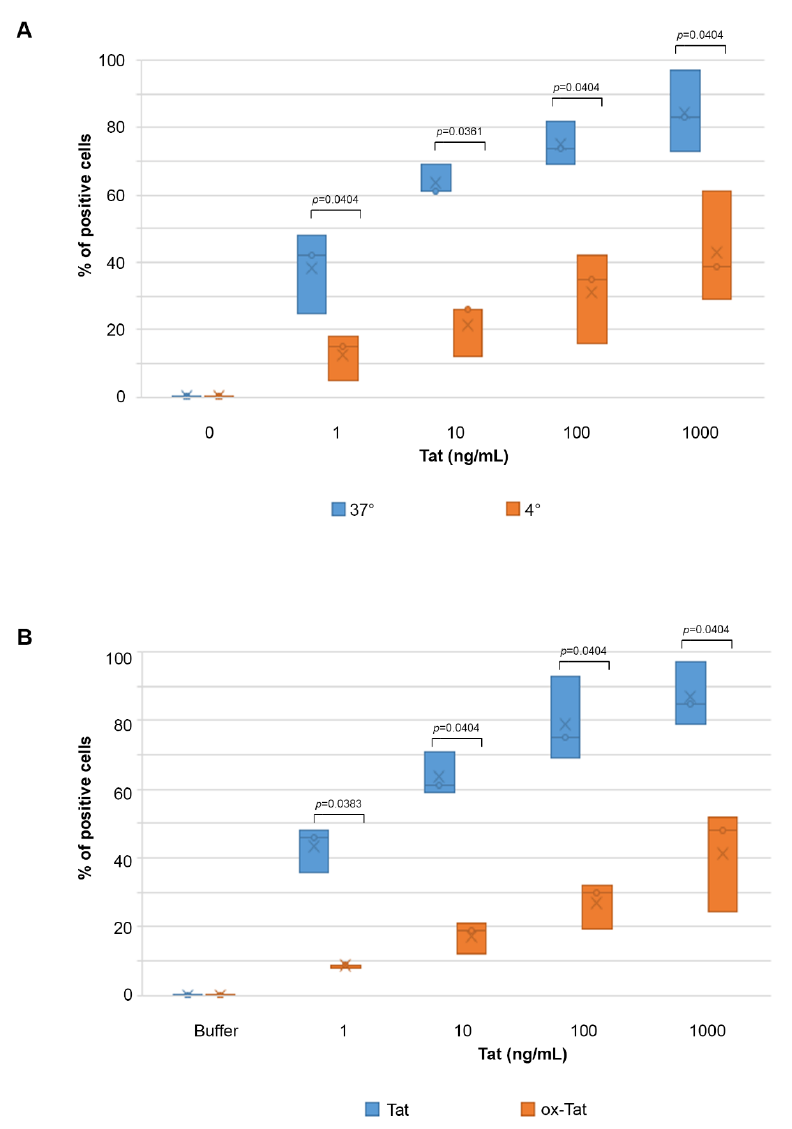
Figure 2. Entry of Tat in IC-HUVEC is reduced by low temperatures or Tat oxidation. ( A ) IC-activated HUVEC were incubated for 10 min at 37 °C (blue plots) or 4 °C (orange plots) with biologically active Tat (1–1000 ng/mL) or its buffer (0 ng/mL). ( B ) IC-HUVEC were incubated for 10 min with 1–1000 ng/mL of biologically active (blue plots) or inactive, oxidized (orange plots) Tat. For both ( A , B ), the detection of intracellular Tat was performed as described in the legend to Figure 1, and the results are expressed as the percentage of positive cells. Box-plot of data obtained from three independent experiments and analyzed by the Mann–Whitney test are shown. Dots indicate individual measures. In all experiments, the fluorescence of permeabilized cells stained with anti-Tat Ab was compared to that of isotype-stained samples and non- permeabilized cells. Similarly, a marked reduction of Tat entry was observed upon Tat protein inactiva- tion by oxidation (see Materials and Methods Section). In fact, the entry of 1, 10, 100, or 1000 ng/mL of oxidized Tat into IC-HUVEC was reduced by 80, 69, 60, and 44%, respec- tively, as compared to native, biologically active Tat ( p < 0.05, Figure 2B).